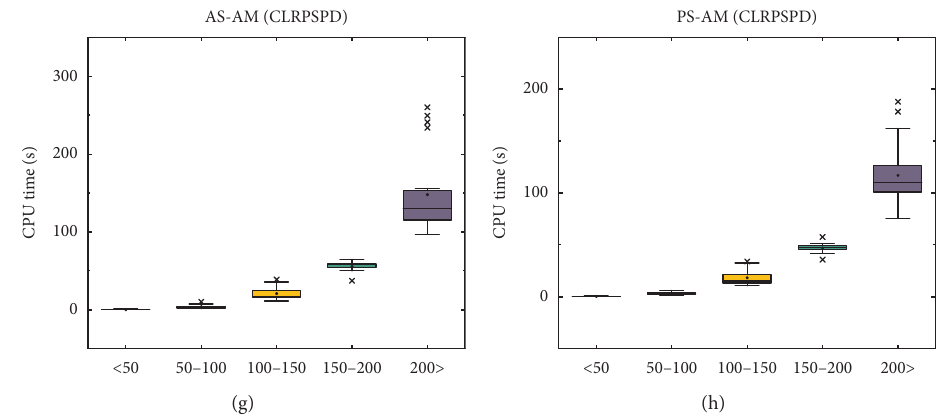
Figure 3: Box plots for relationship between computing time and number of clients.